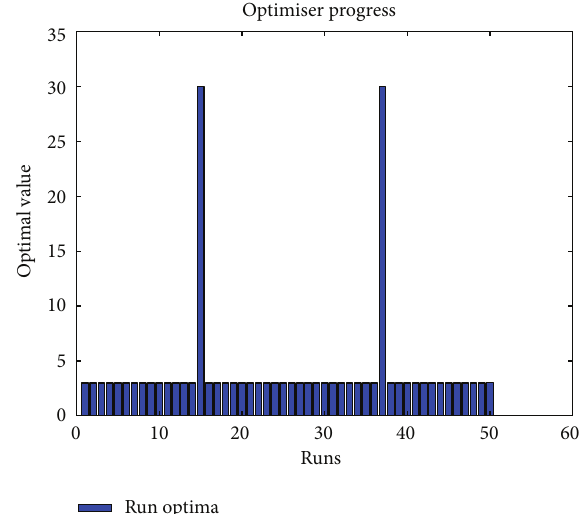
Figure 6: This bar graph shows the result of 50 independent runs of EHS on the Goldstein-Price polynomial. Notice that 48 of the 50 runsconvergedtothecorrectglobalminimum,whiletwoconverged to one of the local minima that is 10 times larger than the global